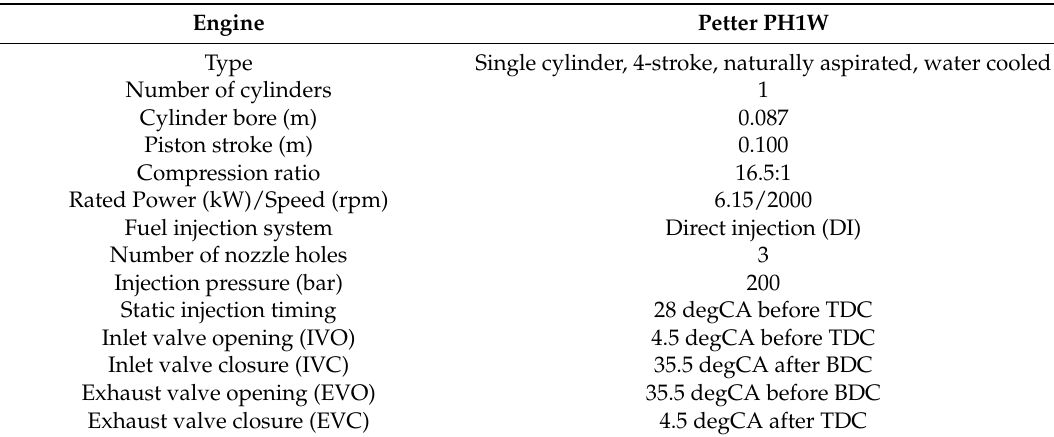
Table 1. Basic geometrical and operational data of the test engine [44].